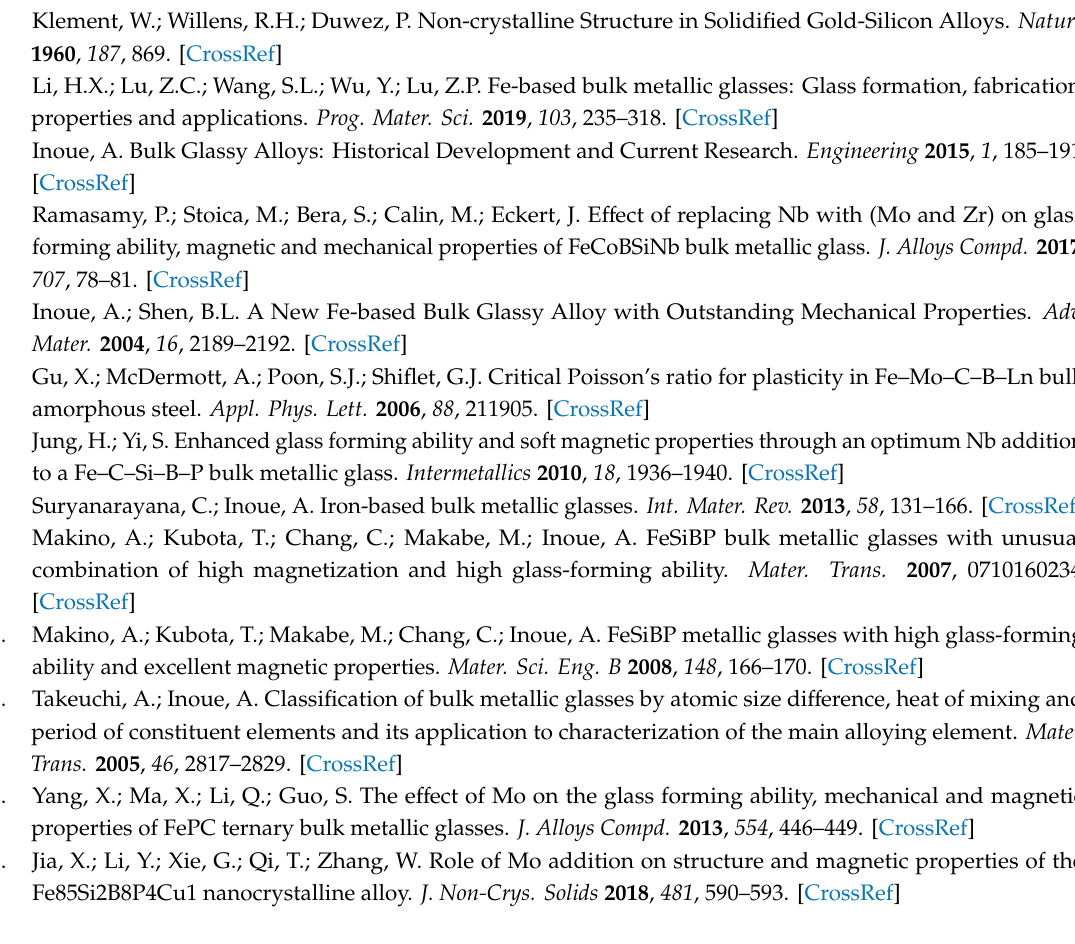
Figure S1: SEAD pattern of the Fe 76 Si 9 B 10 P 5 sample annealed at 1073